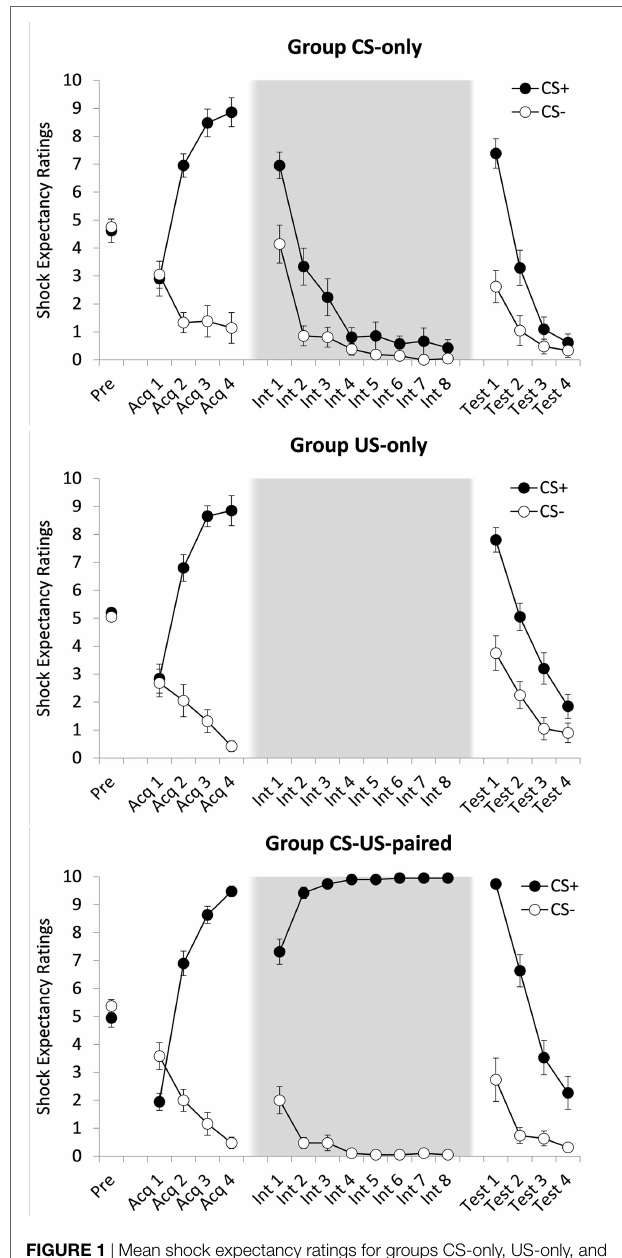
FIGURE 1 | Mean shock expectancy ratings for groups CS-only, US-only, and CS-US-paired as a function of stimulus type (CS + /CS (cid:0) ) and trial. Acq, acquisition trial; Int, intervention trial; Test, test trial. All groups received one CS-pre-exposure trial and four acquisition trials. Four test trials followed eight CS-alone presentations (group CS-only) eight US-alone presentations (group US-only) or eight continued CS–US pairings (group CS–US paired). Background colors represent the experimental contexts. Error bars represent